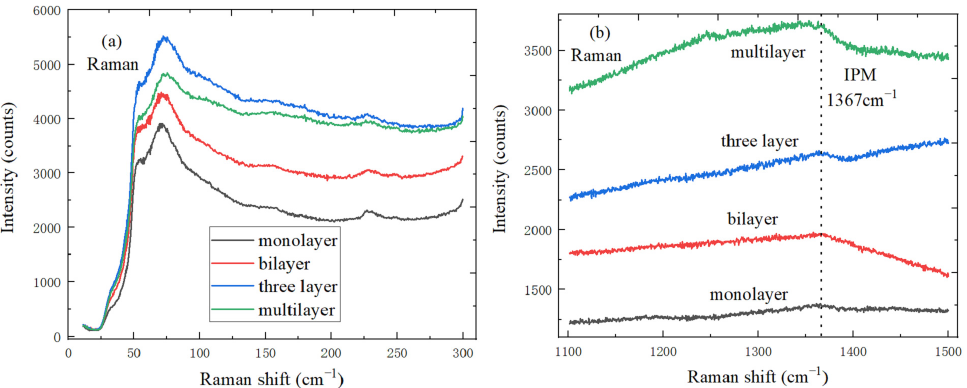
Figure 5. Spectral characteristics of h-BN with different layers ( a ) ISM mode characteristic peak spectrum; ( b ) IPM mode characteristic peak spectrum.